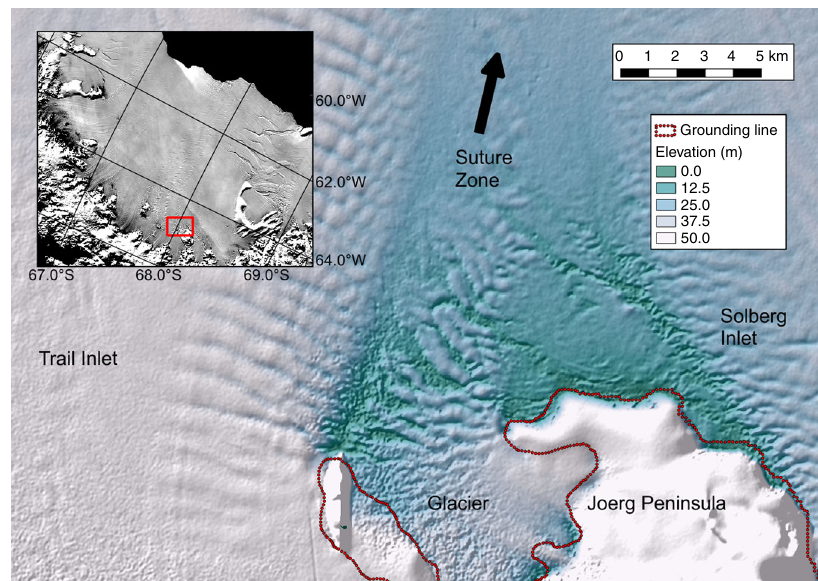
Fig. 3 Formation area of the Joerg Peninsula (JP) suture zone. TanDEM-X Synthetic Aperture Radar (SAR)-derived interferometric DEM for 27 January 2012, as outlined by red box in inset. The red dotted line in the main image shows the grounding line. The unnamed glacier calves blocks of fi rn and meteoric ice into the formation area (ISU-3 in Fig. 4c, d), which are physically elevated (white colours) relative to the thinner mélange (ISU-4, green colours) that forms between them. This heterogeneous mixture of ice blocks and mélange is then compressed laterally into the nascent suture zone by the converging meteoric ice-shelf units derived from Trail and Solberg inlets (ISU-6 in Fig. 4c, d). The diminishing elevation differences between the glacier- derived blocks and the mélange with distance from the JP ’ s tip are then due to surface accumulation of the in situ fi rn (ISU-1) and meteoric ice (ISU-2) layers and the accretion of basal marine ice